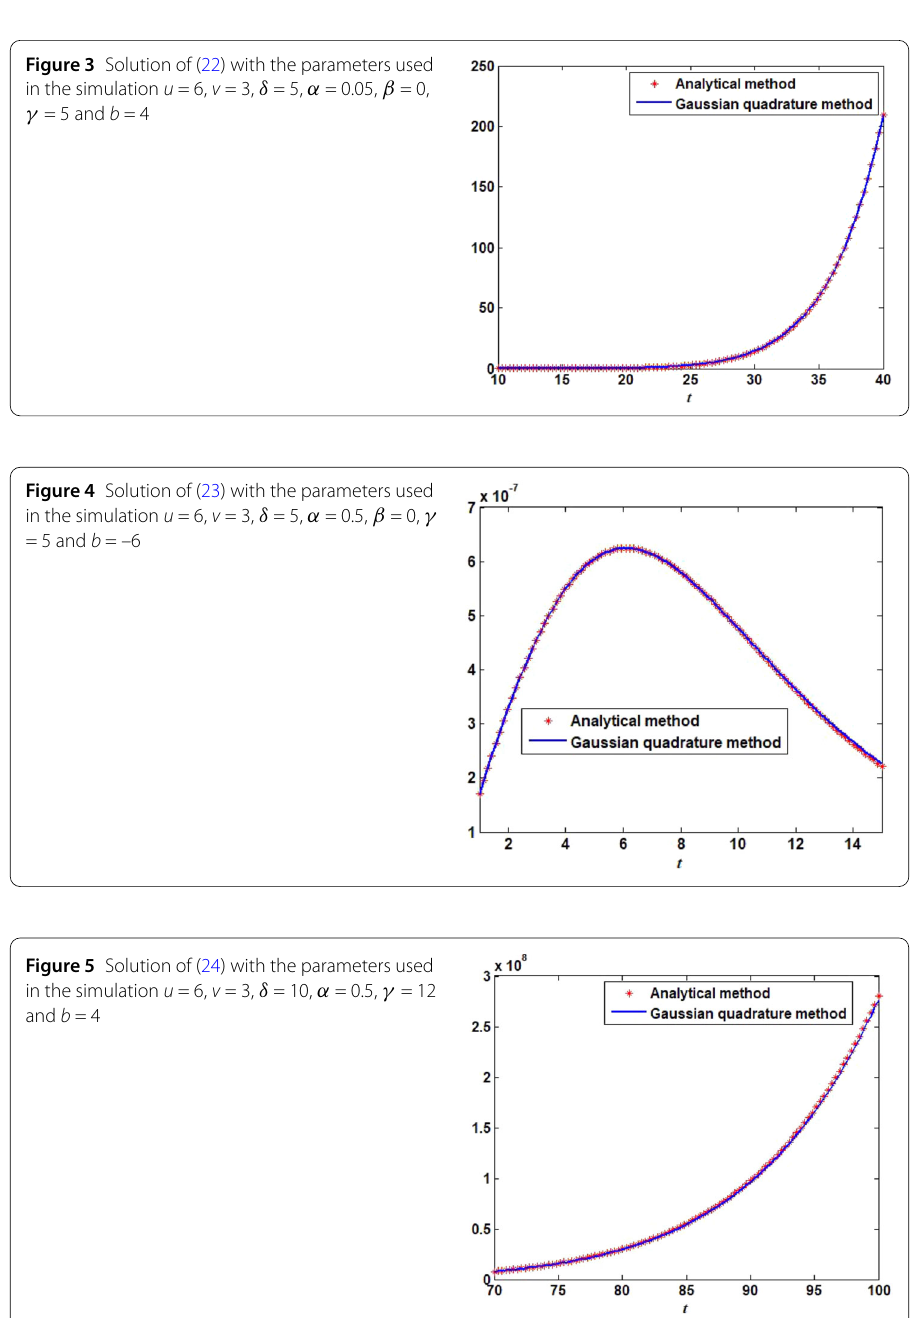
Figure 3 Solution of (22) with the parameters used in the simulation u = 6, v = 3, δ = 5, α = 0.05, β = 0, γ = 5 and b = 4